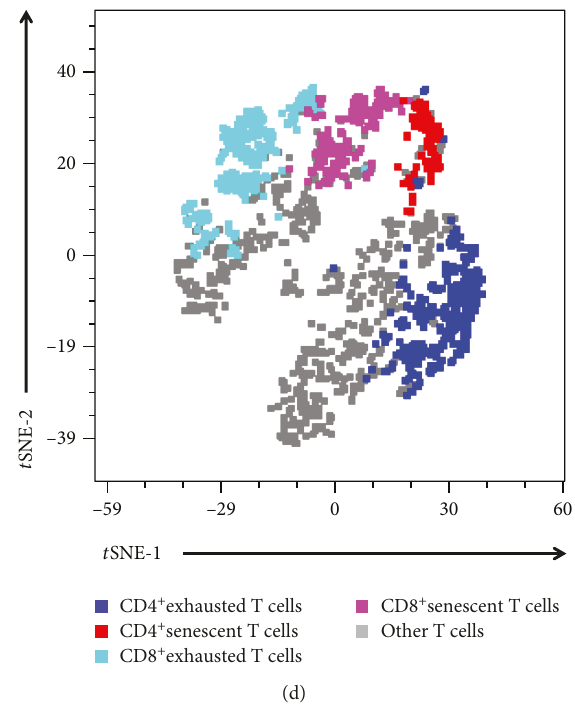
Figure 1: Immunophenotyping of exhausted and senescent T cells in the decidua basalis and decidua parietalis. (a) Representation of the spatial localization of the decidua basalis and decidua parietalis. (b) Schematic representation of select markers expressed by exhausted and senescent T cells. (c) Flow cytometry gating strategy used to identify exhausted and senescent T cells in the decidual tissues. T cells were gated as CD3 + CD56 - cells within the viability and lymphocytic gates, followed by gating for the CD4 + and CD8 + subsets. Exhausted T cells were gated for expression of PD-1, TIM-3, CTLA-4, and LAG-3. Since expression of CTLA-4 and LAG-3 was low, exhausted T cells were de fi ned as PD-1 + TIM-3 + cells within the CD4 + or CD8 + gates. Senescent T cells were gated as KLRG-1 + CD57 + cells within the CD4 + or CD8 + gates. (d) A representative t -distributed stochastic neighbor embedding ( t -SNE) dot plot visualizing exhausted and senescent CD4 + and CD8 + T cells among decidual T cells. Blue — CD4 + exhausted T cells, red — CD4 + senescent T cells, turquoise — CD8 + Table 1: Clinical and demographic characteristics of the patient population used to perform immunophenotyping of exhausted and senescent T cells in the decidua